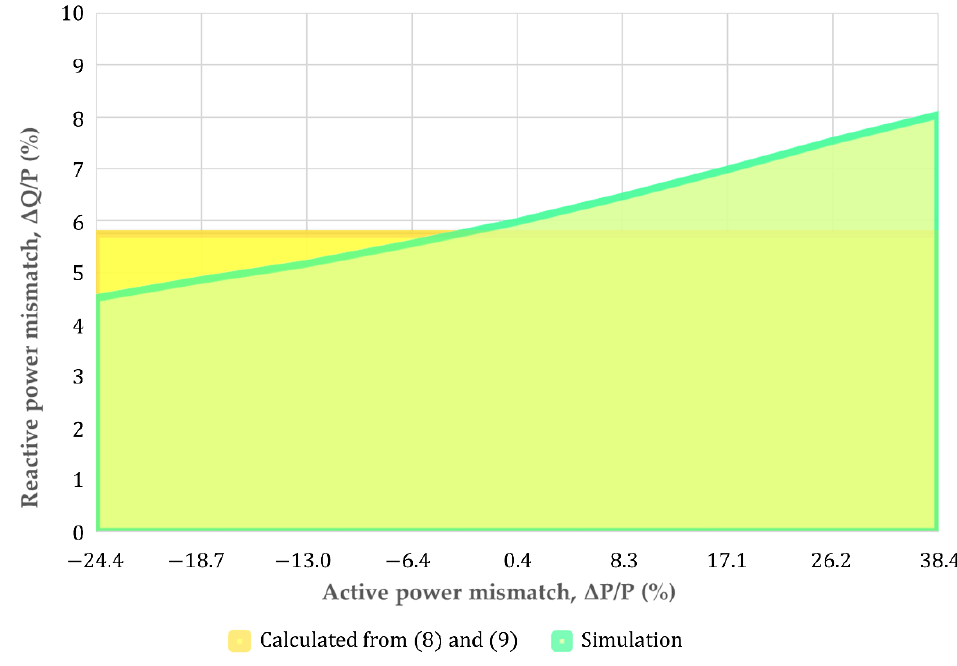
Figure 12. Comparison between the NDZ calculated from (8) and (9) and the NDZ obtained by simulation for ENTSO-E and IEC 62116.